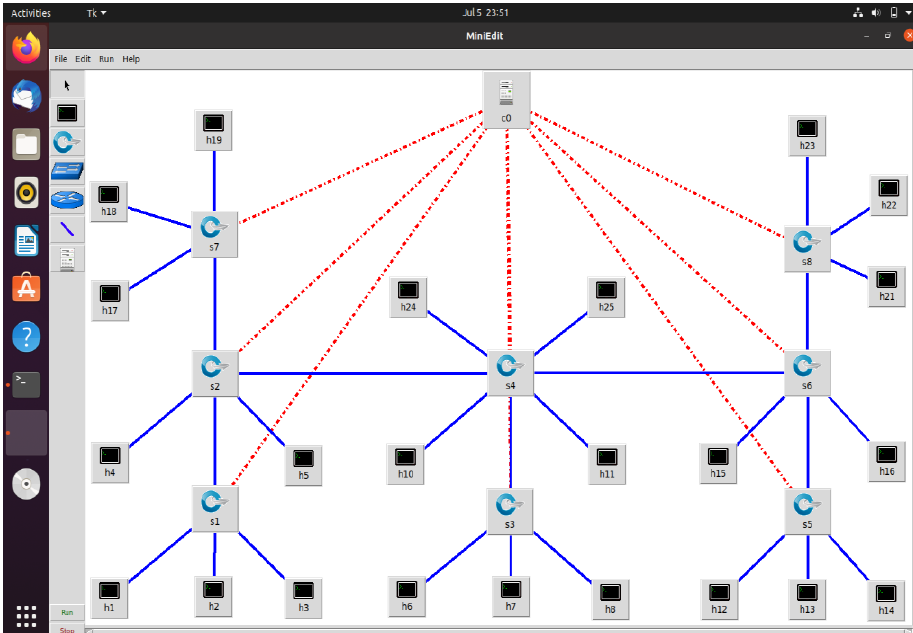
Figure 1. Single-controller SDN Test Network.